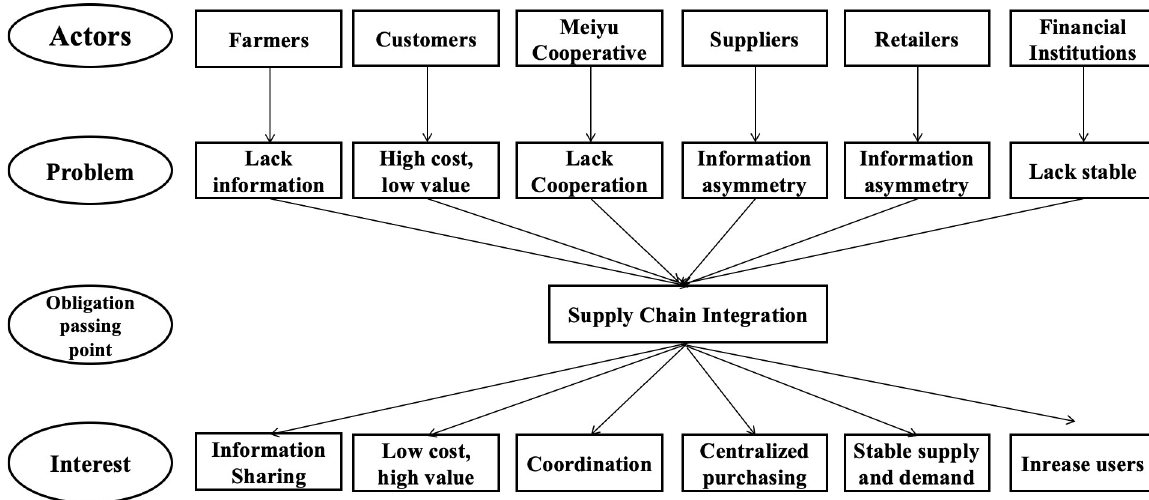
Fig 3. Supply chain integration obligatory passing point for the Meiyu